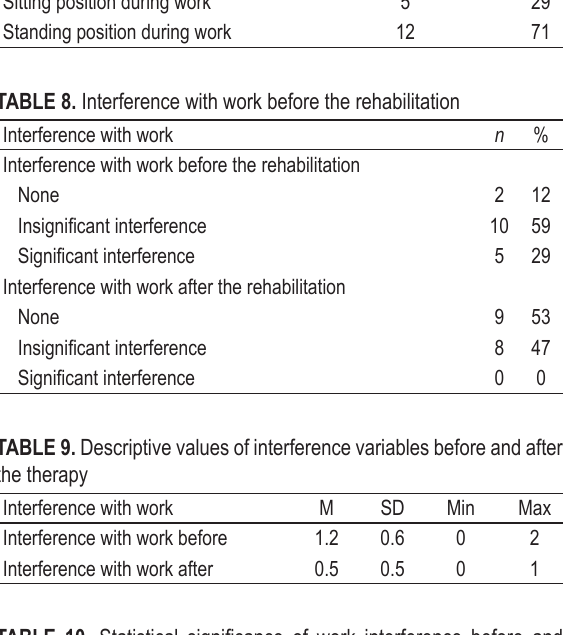
TABLE 10. Statistical significance of work interference before and